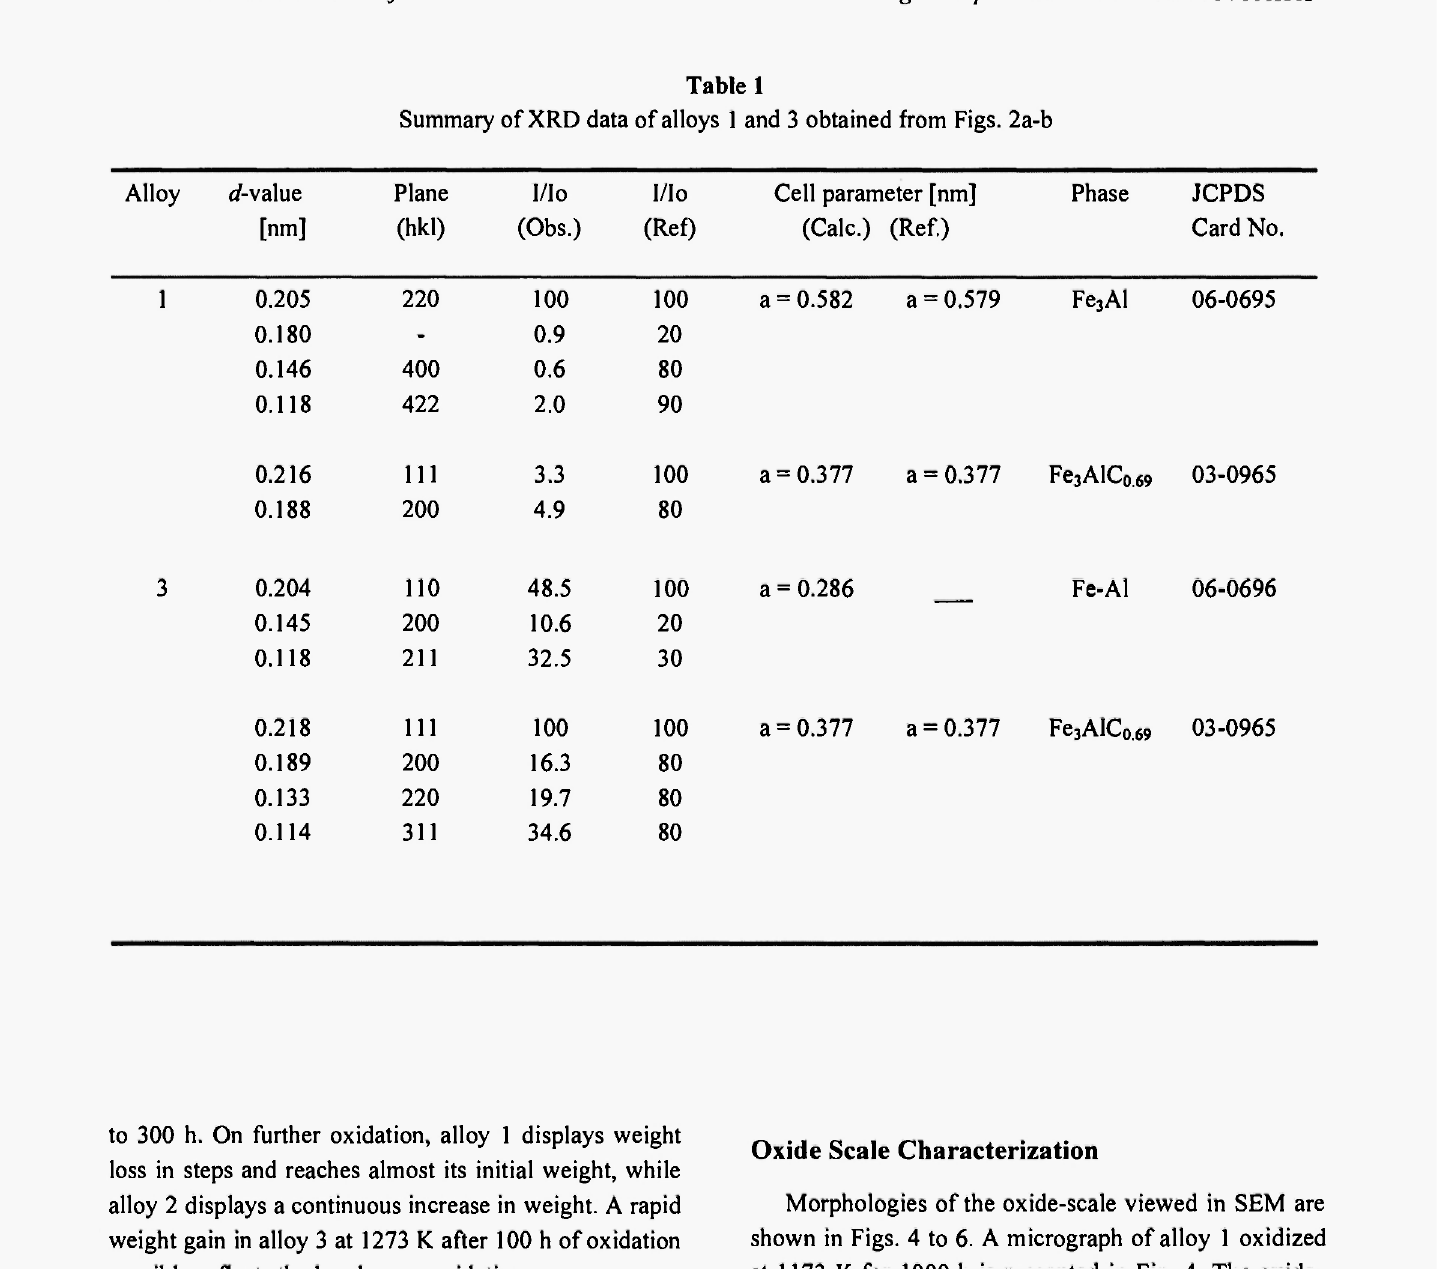
Summary of XRD data of alloys 1 and 3 obtained from Figs.